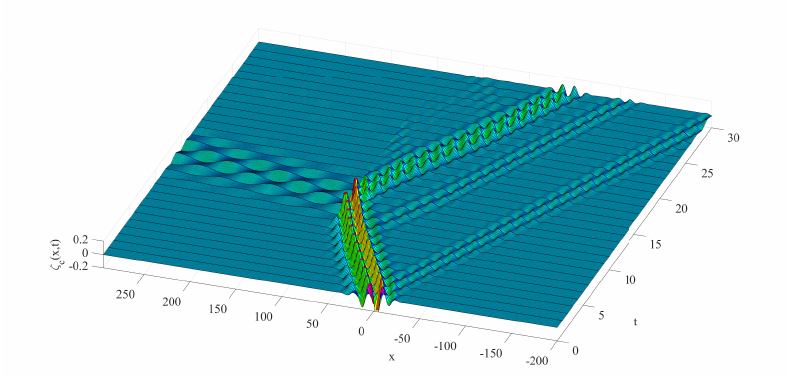
Figure 17. Variation of the free surface displacement ζ c ( x , t ) (m) versus x (m) and time t (s) in the case of a semi-infinite plate in the presence of a single trench.